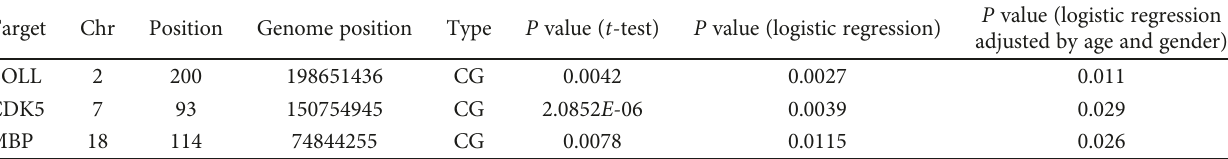
Figure 5: Methylation levels at DMRs between control and patients with GO based on the enlarged population. DMRs: di ff erentially DNA methylated regions. Table 3: Signi fi cant DMRs at candidate genes between patients with GO and controls based on the enlarged population (48 cases vs. 24